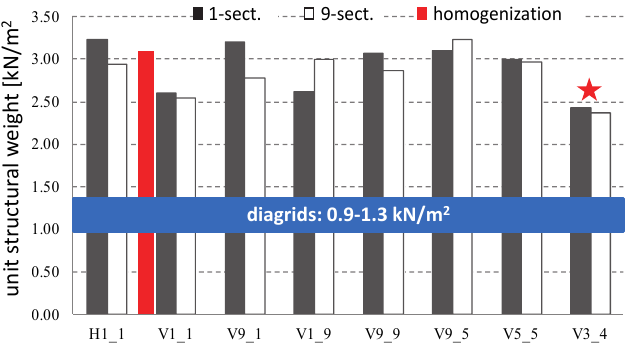
Figure 25: Structural weight of Voroni patterns: 1-section and 9-sections